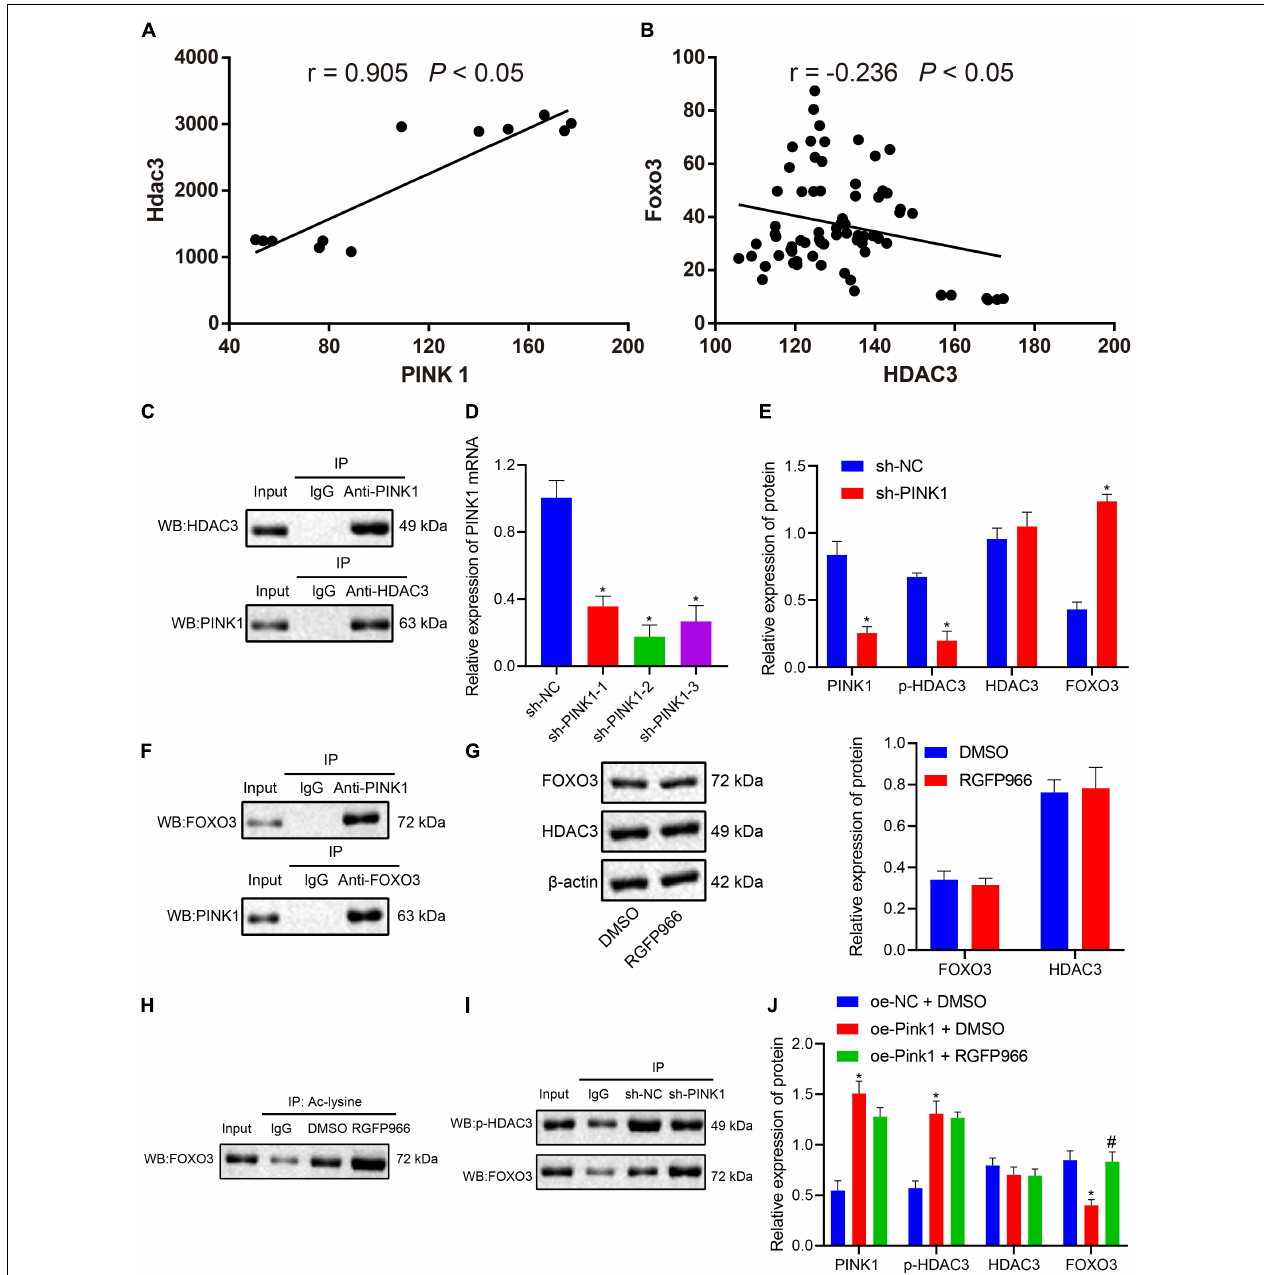
FIGURE 5 | PINK1 accelerates HDAC3 phosphorylation and further restricts FOXO3 expression. (A) Correlation of PINK1 expression and HDAC3 expression in NSCs in the GSE143388 dataset. (B) Correlation of HDAC3 expression and FOXO3 expression in NSCs in the GSE134688 dataset. (C) The interaction between HDAC3 and PINK1 in NSCs, as examined by Co-IP assay and western blot. (D) Interference of different sh-PINK1-1, sh-PINK1-2, and sh-PINK1-3 sequences on PINK1 expression in NSCs, as measured by RT-qPCR. (E) The expression of PINK1, p-HDAC3, HDAC3, and FOXO3 in response to PINK1 silencing, as measured by western blot. (F) The interaction between PINK1 and FOXO3 in NSCs with PINK1 knockdown, as examined by Co-IP assay. (G) The protein level of HDAC3 and FOXO3 in NSCs after RGFP966 treatment, as measured by western blot. (H) The acetylation level of FOXO3 in the presence of RGFP966 treatment, as detected by Co-IP assay. (I) The interaction between p-HDAC3 and FOXO3, as detected by Co-IP assay and western blot. (J) The protein levels of PINK1, p-HDAC3, HDAC3, and FOXO3 after treatment with the oe-PINK1 plasmid alone or in combination with RGFP966 treatment, as measured by western blot. * p < 0.05 compared with the sh-NC group or DMSO group or oe-NC + DMSO group. # p < 0.05 compared with the oe-PINK1 + DMSO group. The measurement data were summarized by mean ± standard deviation. Results between two groups were compared by the unpaired t -test. Data comparison among multiple groups was analyzed by one-way ANOVA with Tukey’s post hoc